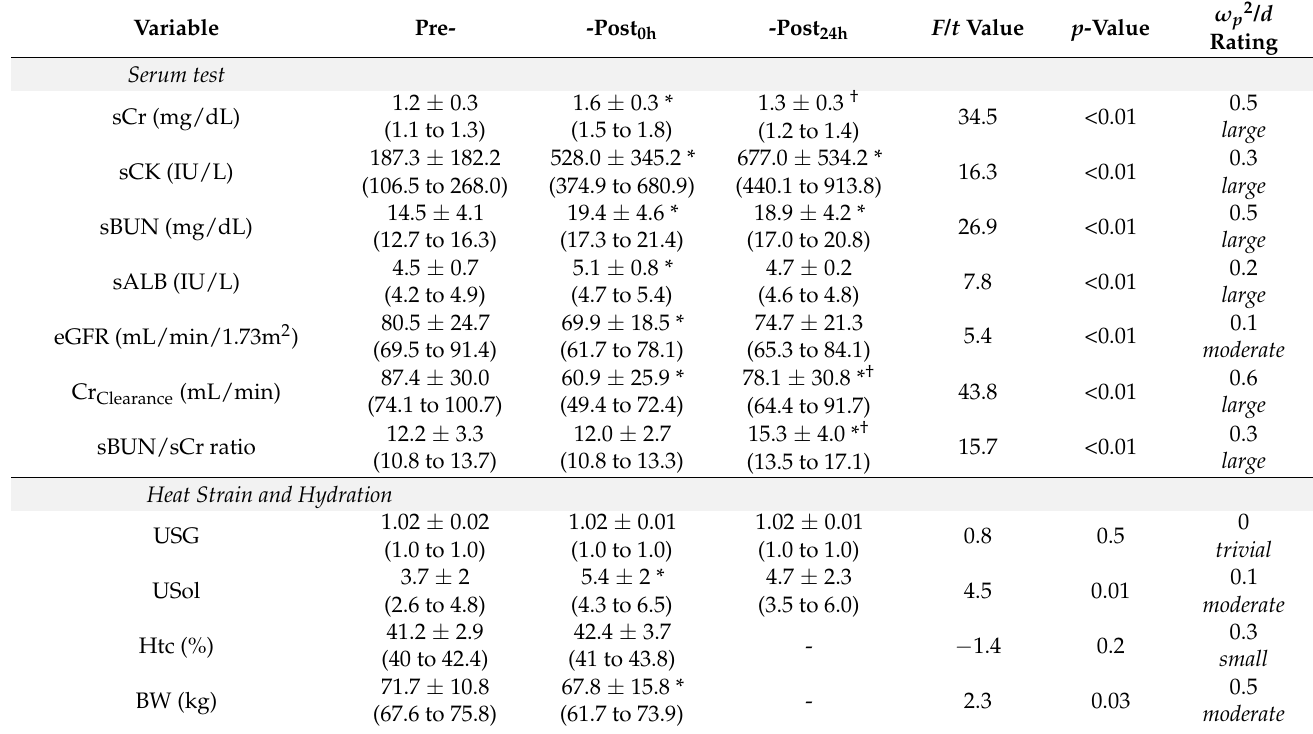
Table 1. Pre-, -Post changes in serum, heat strain, and hydration